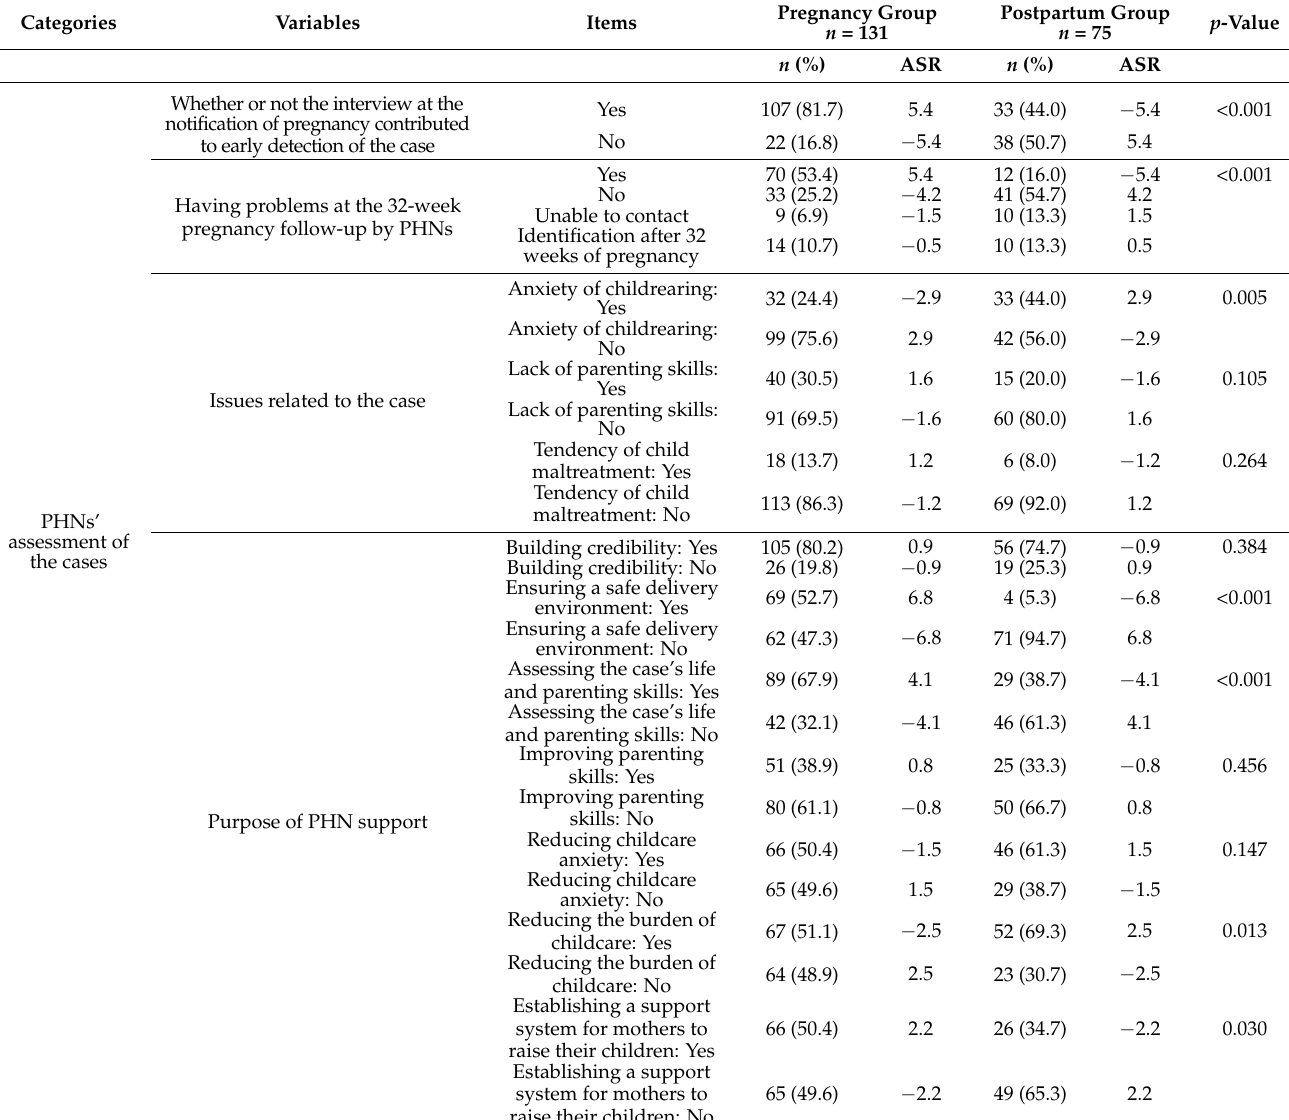
Table 2. PHNs’ assessment of the cases and their maternal and child healthcare services use ( N = 206).